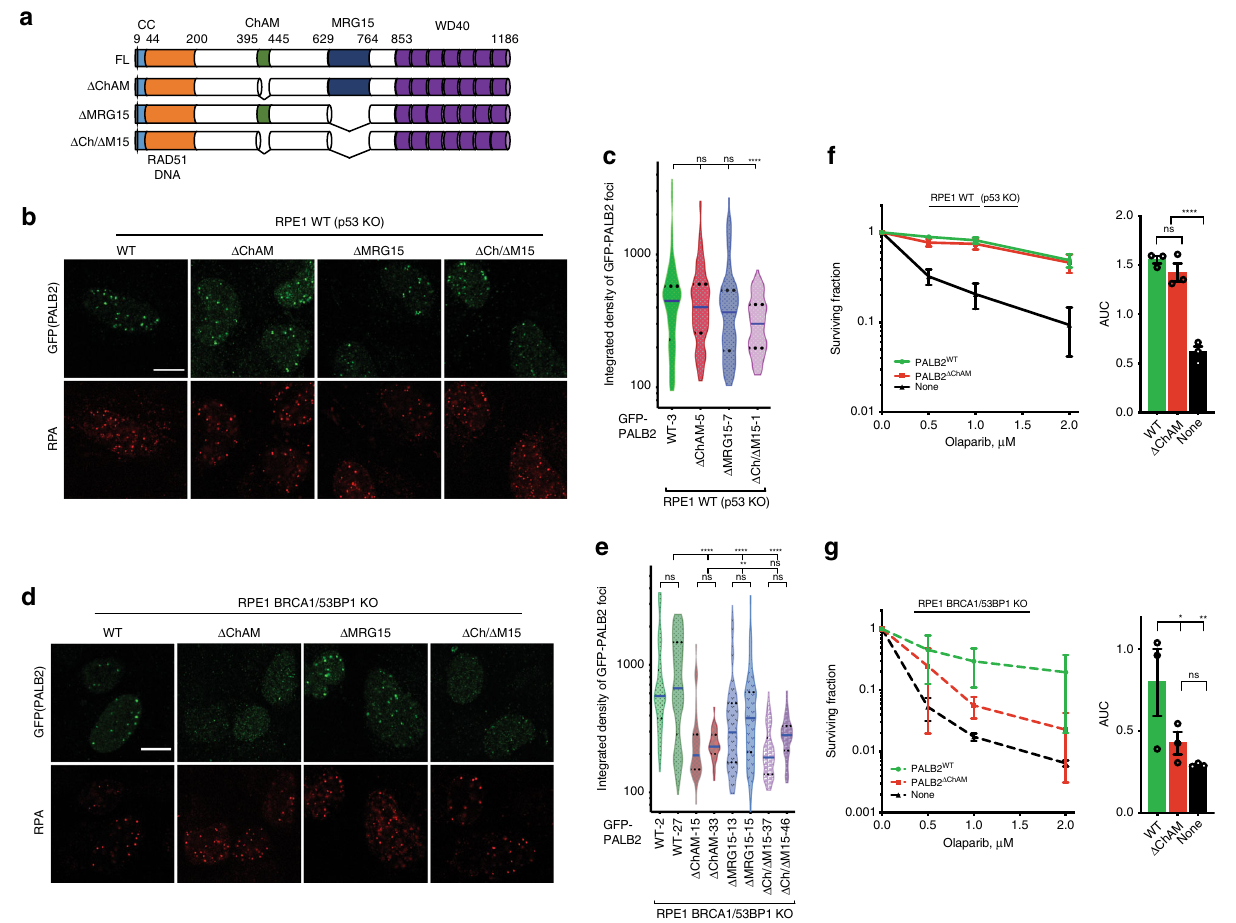
Fig. 3 ChAM of PALB2 is important for PALB2 recruitment to DSB sites in BRCA1/53BP1-de fi cient cells. a Domain structure of GFP-tagged derivatives of PALB2 stably integrated at the FRT site in Tet repressor-expressing RPE1 cells. b Representative images of RPE1 p53 KO cells siRNA-depleted of endogenous PALB2 and complemented with indicated GFP-PALB2 variants. Cells were exposed to 6 Gy of IR and 6 h later fi xed and stained with anti-GFP (to detect PALB2) and anti-RPA antibodies. Scale bars, 10 µ m. Additional images are in Supplementary Fig. 4a. c Violin plots represent quanti fi cation of the integrated density of GFP-PALB2 IRIF in RPA-positive cells following exposure to 6 Gy of IR. Numbers next to the names of the cell lines indicate numbers of the individual clones used in the experiment. d Representative images of RPE1 p53/BRCA1/53BP1 KO cells siRNA-depleted of endogenous PALB2 and complemented with indicated GFP-PALB2 variants. Cells were treated as in ( a ). Scale bars, 10 µ m. Additional images are in Supplementary Fig. 4b. e Violin plots represent quanti fi cation of the integrated density of GFP-PALB2 IRIF in RPE1 p53/BRCA1/53BP1 cells following exposure to 6 Gy of IR. Numbers next to the names of the cell lines indicate numbers of the individual clones used in the experiment. f , g Clonogenic survivals of RPE1 p53 KO ( f ) or p53/BRCA1/ 53BP1 KO ( g ) cells complemented with either PALB2 WT or PALB2 Δ ChAM in response to indicated doses of olaparib. Lower panels show area under curve (AUC); n ≥ 3. The bars represent mean ± s.e.m.; one-way ANOVA; * P < 0.05, ** P < 0.01, **** P < 0.0001; ns, not signi fi cant ( P ≥ 0.05); n = 3 independent experiments. Source data are provided as a Source Data fi